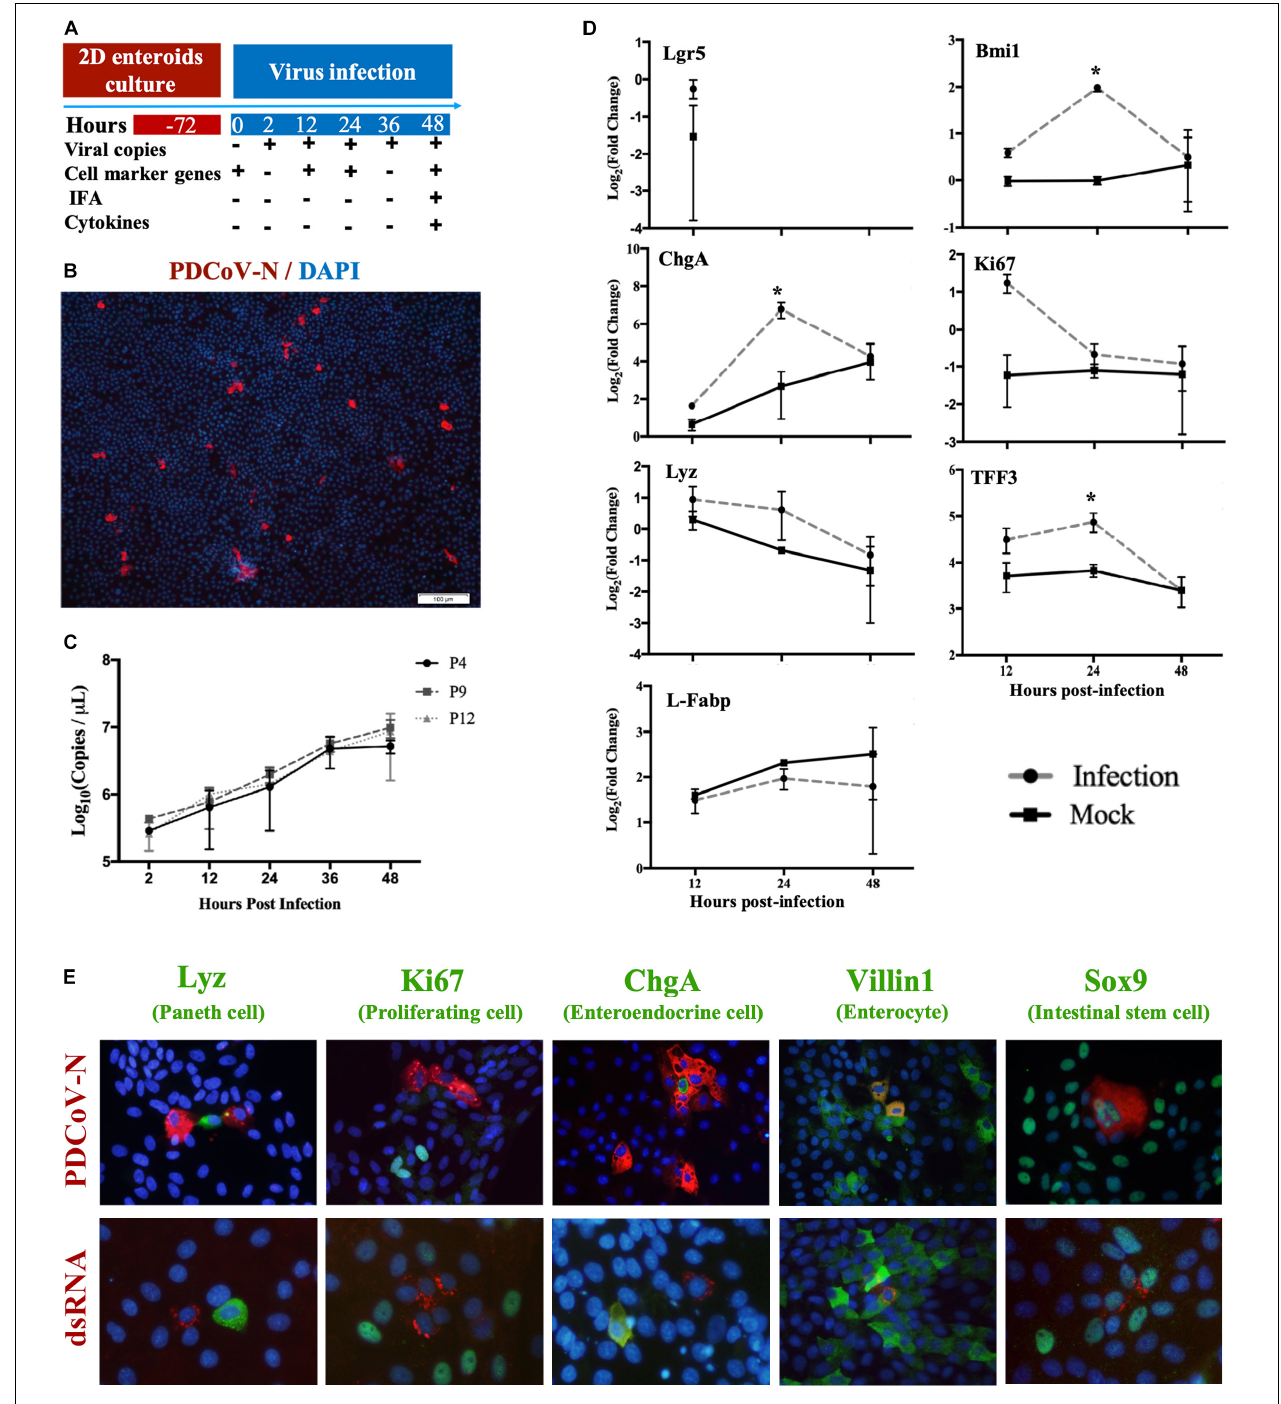
FIGURE 5 | Infection of MPIEs with PDCoV. (A) The schedule of sample collection after infection of MPIEs by PDCoV. (B) Immunostaining of MPIEs infected with PDCoV for 48 hs. PDCoV is shown in red using the antibody against viral structural protein PDCoV-N. DAPI-stained nuclei are shown in blue (Scale bar = 100 µ m). (C) Viral genome copies detected in MPIEs at different times of PDCoV infection (2, 12, 24, 36, and 48 h) by RT-qPCR ( n = 3, mean ± SD). (D) The transcriptional changes of the selected marker genes of the infected cells at 12, 24, and 48 h normalized to 0 h controls. Mock-infected cells were used as controls. (* p < 0.05). (E) Double immunofluorescence labeling of the jejunal MPIEs after 48 h of infection with PDCoV. Paneth cells, proliferating cells, entero-endocrine cells, enterocytes, and intestinal stem cells were labeled with Lyz, Ki67, ChgA, Villin1, and Sox9 (green), respectively. PDCoV was labeled with anti-PDCoV N protein antibody (red). DAPI was used for nuclear